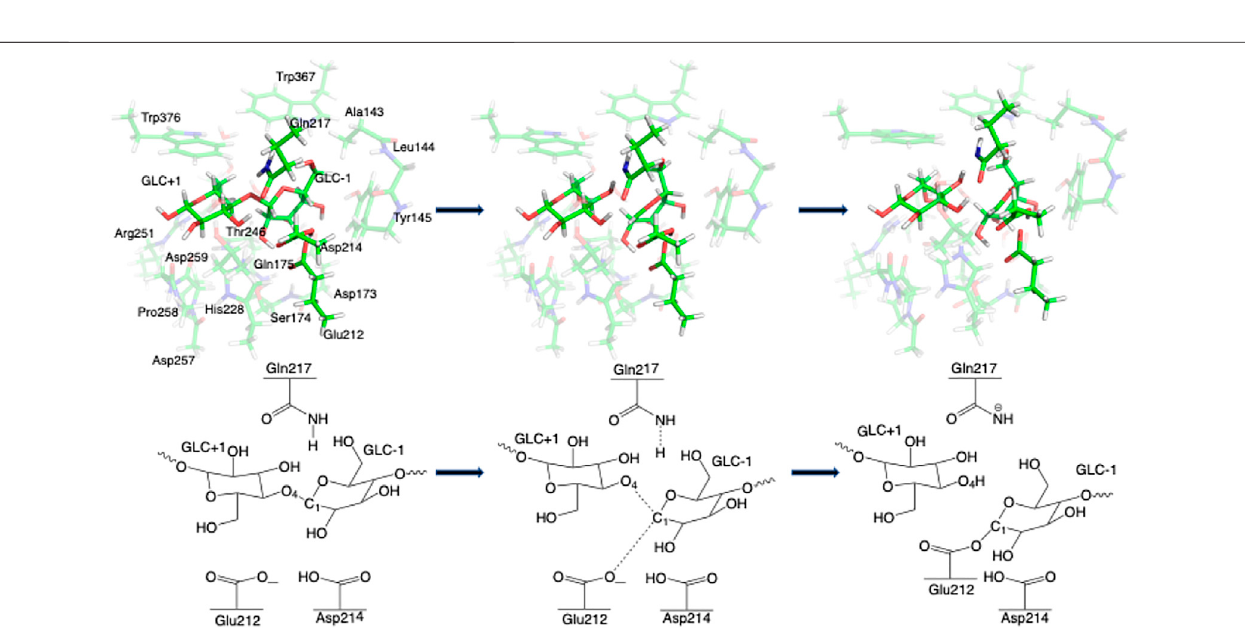
Frontiers in Chemistry |